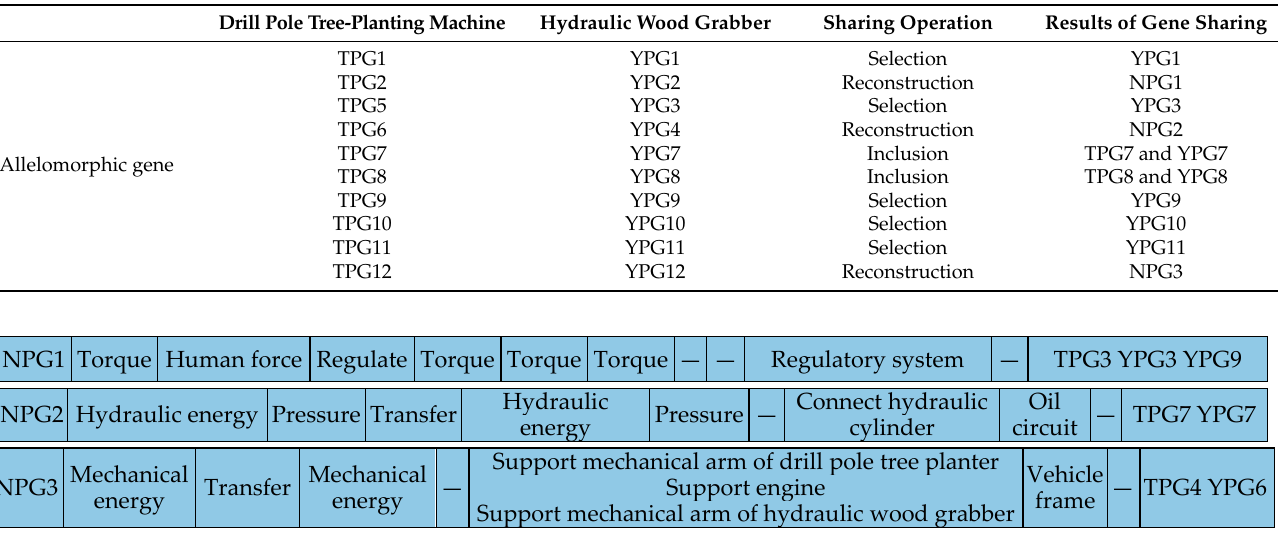
Figure 27. Results of the reconstruction operation of allelomorphic genes.